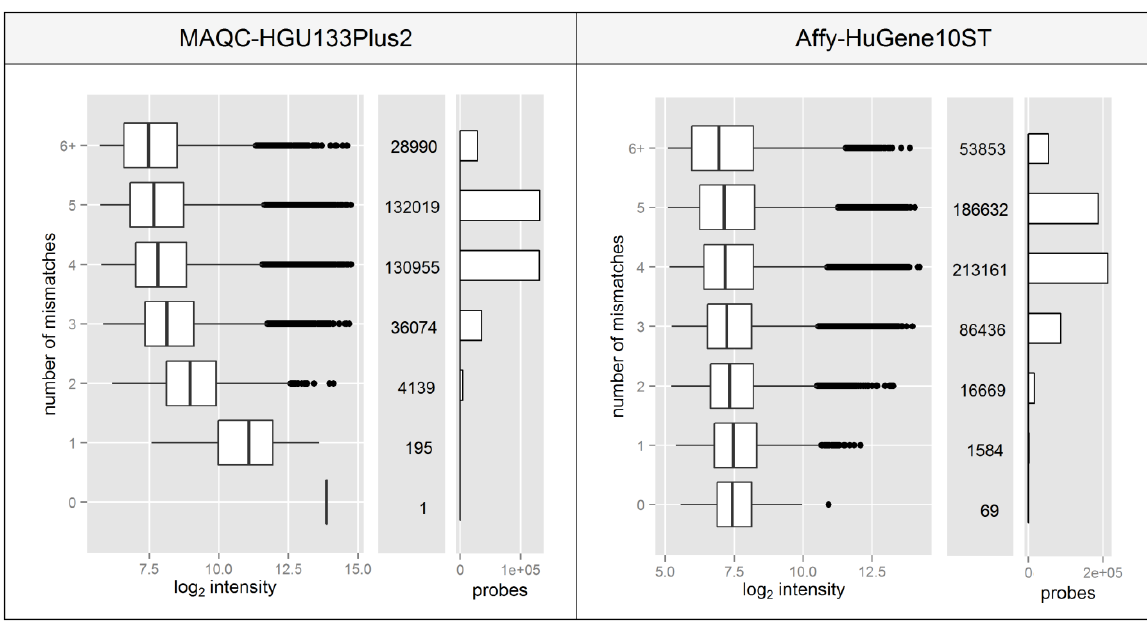
with zero to over six mismatches. Bar plots and corresponding numbers on the right side